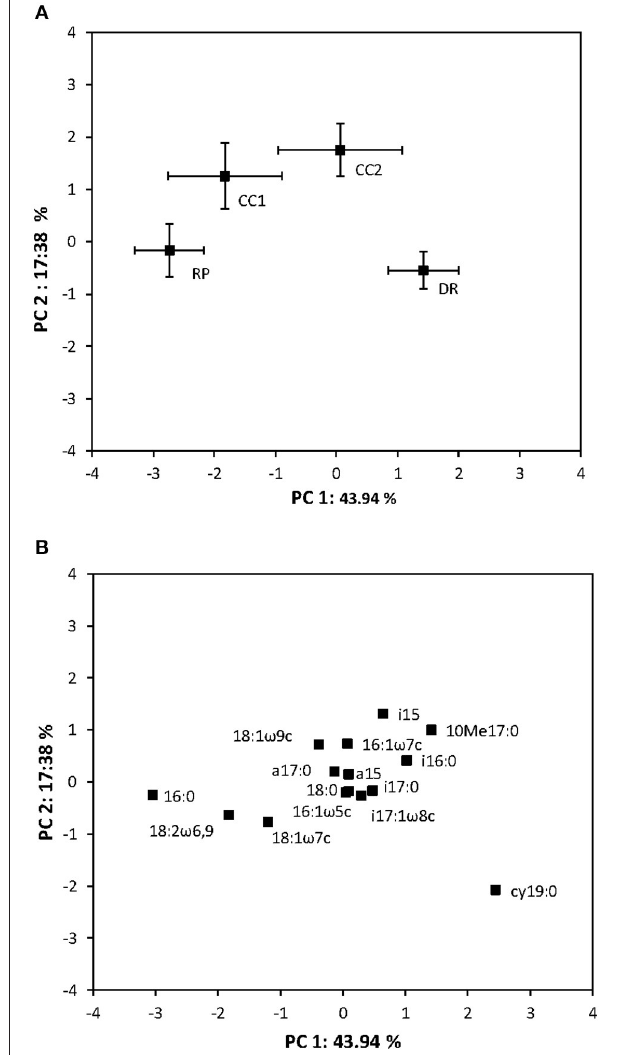
FIGURE 2 | Principal component analysis ordination showing (A) soil microbial communities based on PLFA abundance (mol%) in the dispersed-retention (DR) treatment, the retention patch (RP), in the clear-cut treatment (CC, 9m, or more from the retention patch) and in the clear-cut edge treatment (CCE, within 9m of the retention patch). (B) The relative contributions of individual PLFAs to the community structure. Horizontal and vertical error bars represent standard